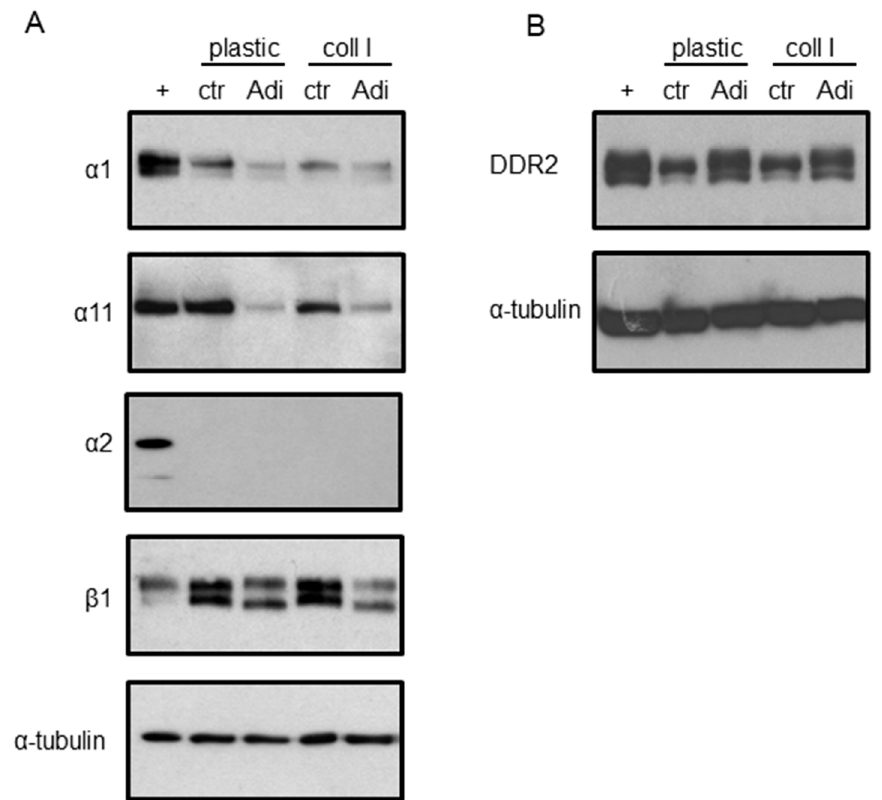
Figure 6. Expression of collagen I receptor molecules. ASCs, plated on regular plastic supports or supports coated with collagen I, were held for 9 days in standard DMEM medium (ctr) or in adipogenic medium (Adi). Protein extracts were subjected to western blot and tested for ( A ) α 1, α 2, α 11, β 1 integrin, and ( B ) DDR2. Equal loading was monitored by using antibodies directed against α -tubulin. The blots show representative results ( n = 3). + indicates positive controls.